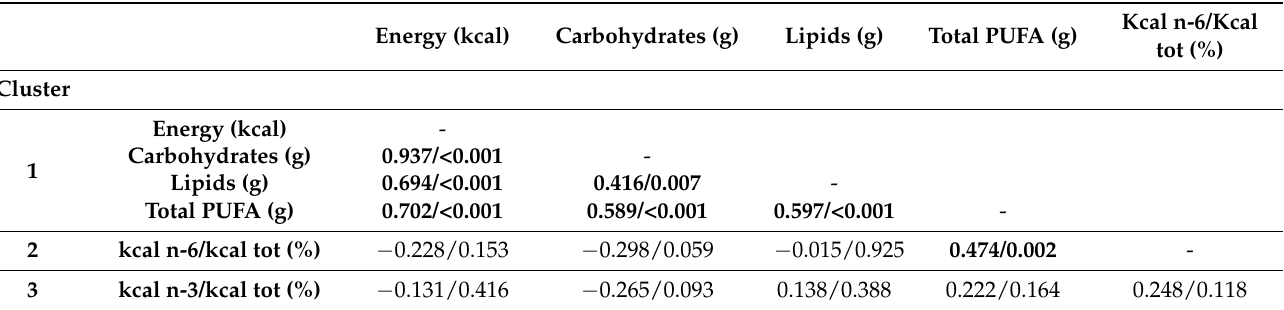
Table A3. Pearson’s partial correlations (controlling for age) of nutritional information and identifica- tion of the four clusters of inter-related variables ( n = 42). Reported values are Pearson’s correlation index r/ p -value. In bold, significant